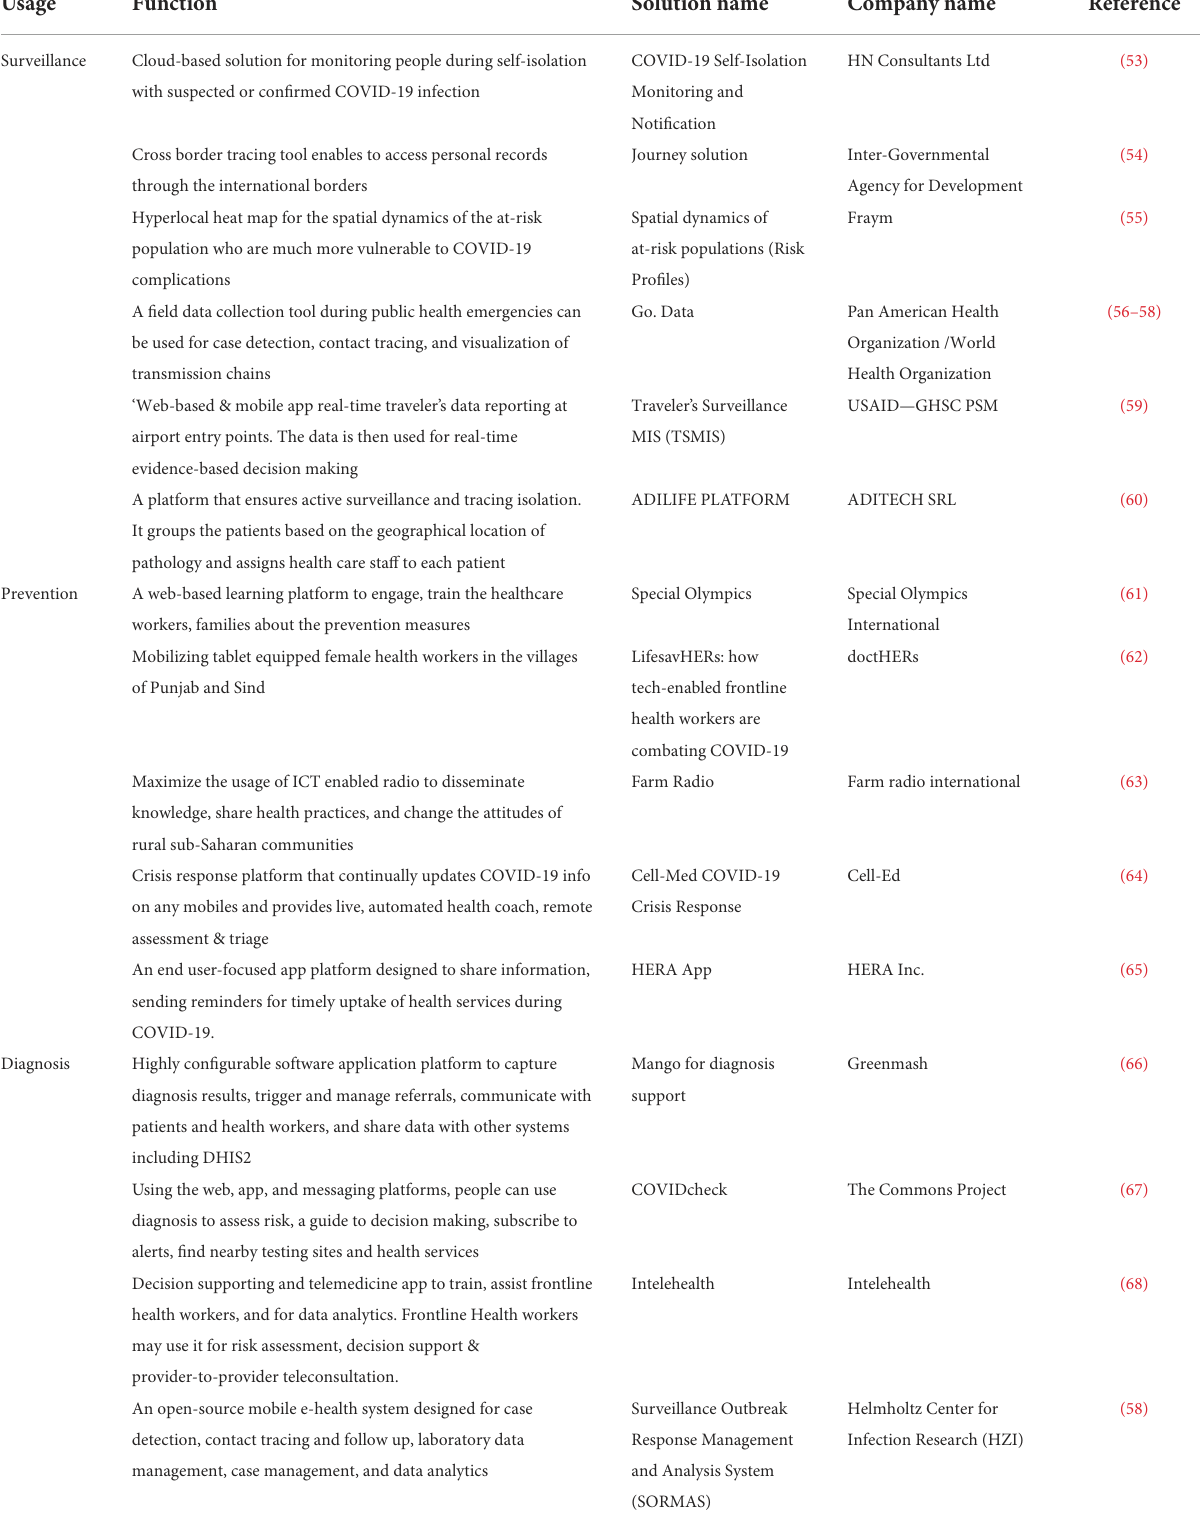
TABLE 1 List of digital solutions for countries to combat